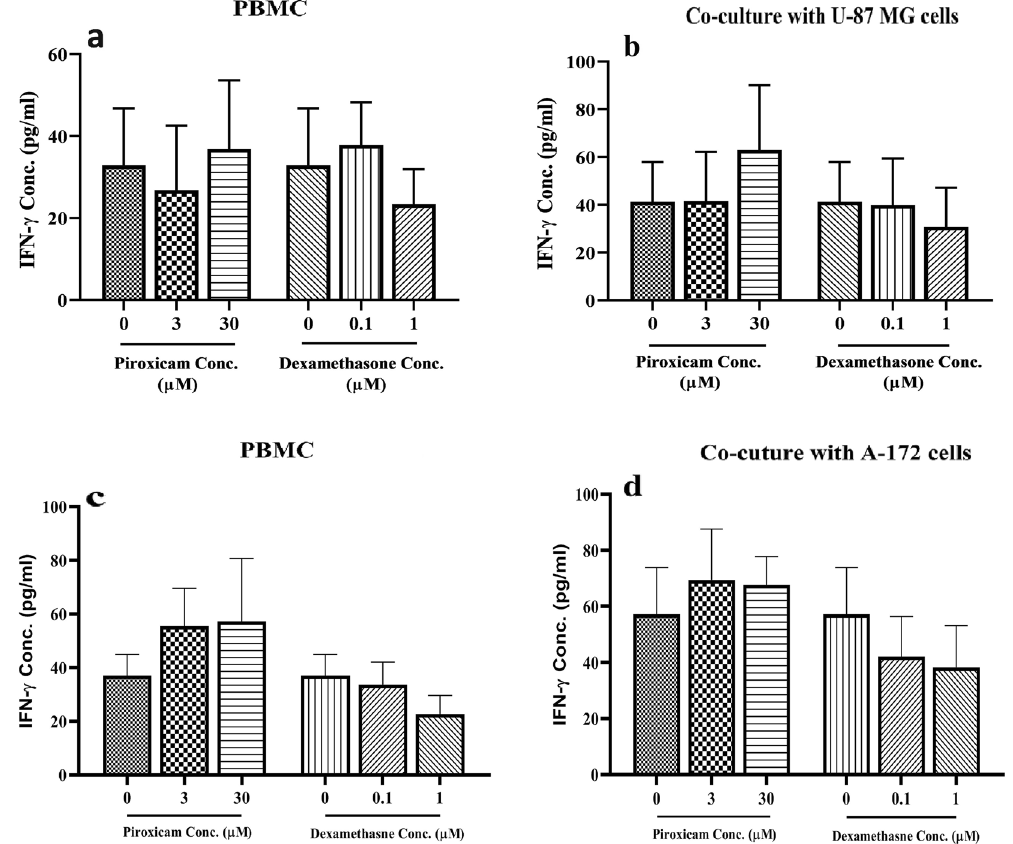
Figure 8. The effect of drugs on the IFN-γ levels of T cells in PBMCs alone or in co-culture condition. The effect of dexamethasone and piroxicam was measured on the IFN-γ levels of T cells in PBMCs alone ( a, c ), and in co-culture with U-87 ( b ) (n = 5), and A-172 ( d ) (n = 4) cells. The graphs show the mean ± SD. Significant changes are indicated with asterisk (* p < 0.05, ** p < 0.01, *** p < 0.001, **** p <